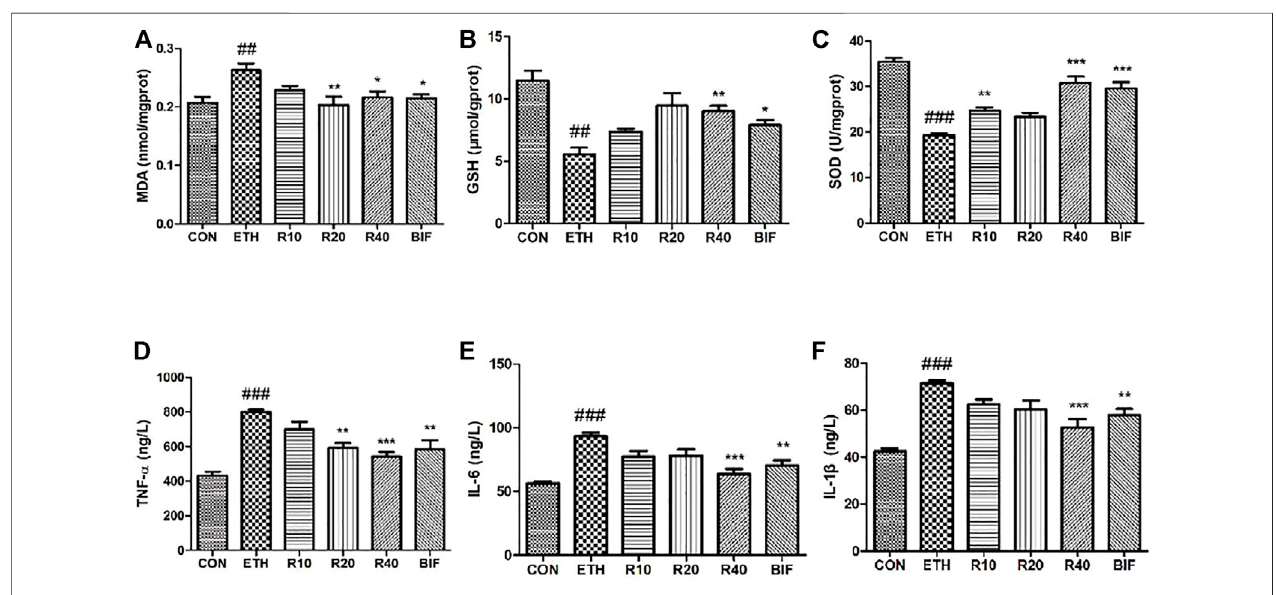
FIGURE2| Effects ofROFonthelevelofoxidativestressindicatorsandthesecretionofin fl ammatorycytokinesinALDmice.ThelevelsofMDA (A) ,GSH (B) ,SOD (C) , TNF- α (D) , IL-6 (E) , and IL-1 β (F) . Mean ± SEM ( n = 6). * p < 0.05, ** p < 0.01, and *** p < 0.001 vs. the ETH group. ### p < 0.001 vs. the CON group.